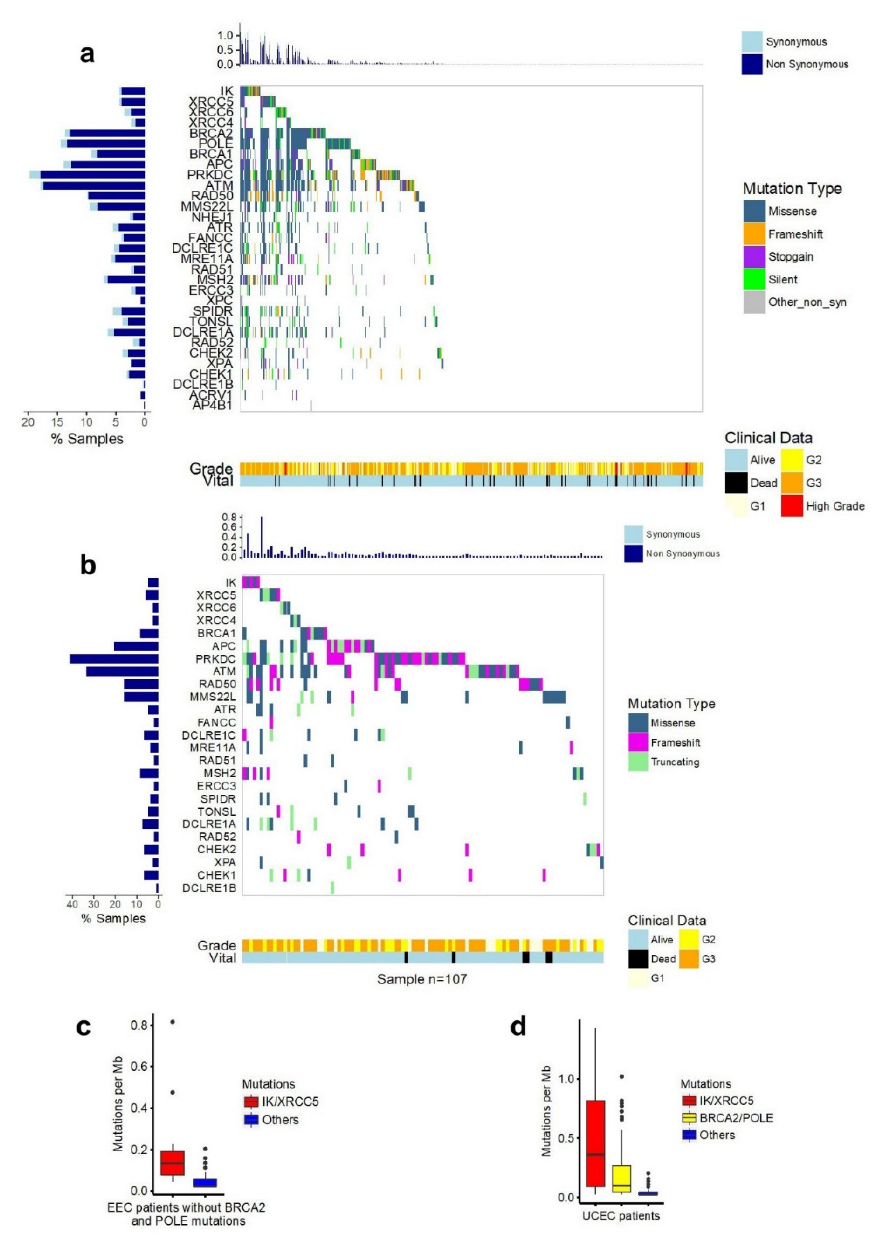
Figure 5. CoMut plot of DNA repair genes and mutation burden of patients with IK/Ku80 mutations. ( a ) CoMut plot of DNA repair genes. The grade and vital status information of 547 EEC patients in TCGA were included. The somatic mutations for 3 ′ UTR and 5 ′ UTR were excluded. Truncating category is for frameshift, stop-gain, stop-loss, and nonsense mutations. ( b ) coMut plot of DNA repair genes for patients without BRCA2/POLE mutations. ( c ) Excluding impact of mutation of BRAC2 or POLE on mutation burden of other DNA repair genes, IK or XRCC5(Ku80) mutations resulted in significantly higher mutation burden than wild-type. p < 1.0 × 10 − 7 , Mann–Whitney U test. ( d ) Patients with EEC were divided into 3 groups: IK/XRCC5 (patients with IK and/or XRCC5 mutations with or without BRCA2/POLE mutations); BRCA2/POLE (patients with mutations of BRCA2 and/or POLE mutations, but not IK/XRCC5 mutations); and all others (patients without IK/XRCC5 or BRCA2/POLE mutations). IK/XRCC5 vs. BRCA2/POLE , p < 1.0 × 10 − 5 , Mann–Whitney U test; BRCA2/POLE vs. others, p <1.0 × 10 − 12 , Mann–Whitney U